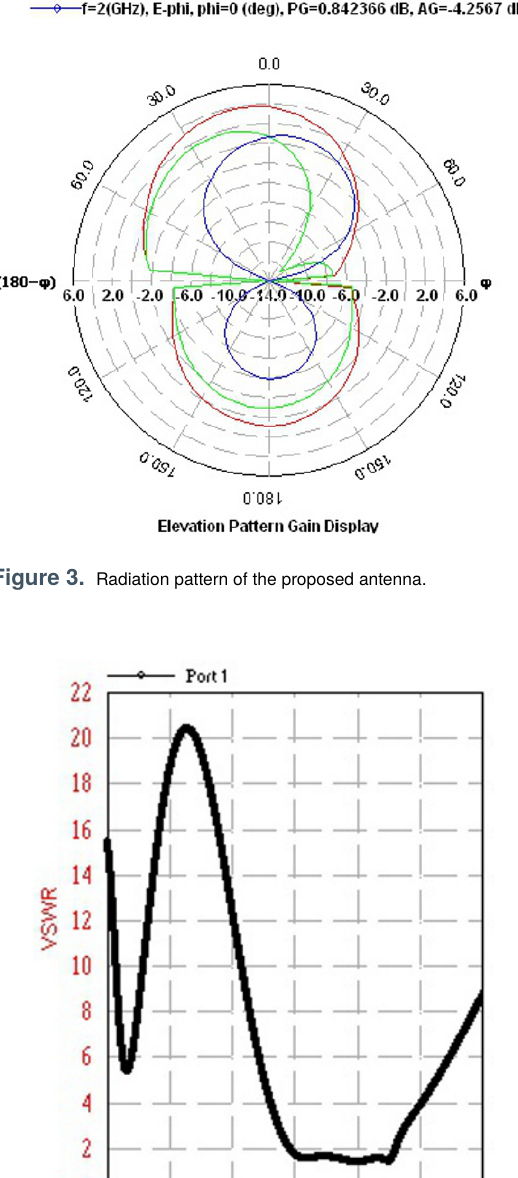
mum achievable gain of the designed antenna is 10.76 dBi with a appreciably good efficiency of 78%. The simple coaxial vertical probe feed is used as a feeding technique to drive the stacked patch.